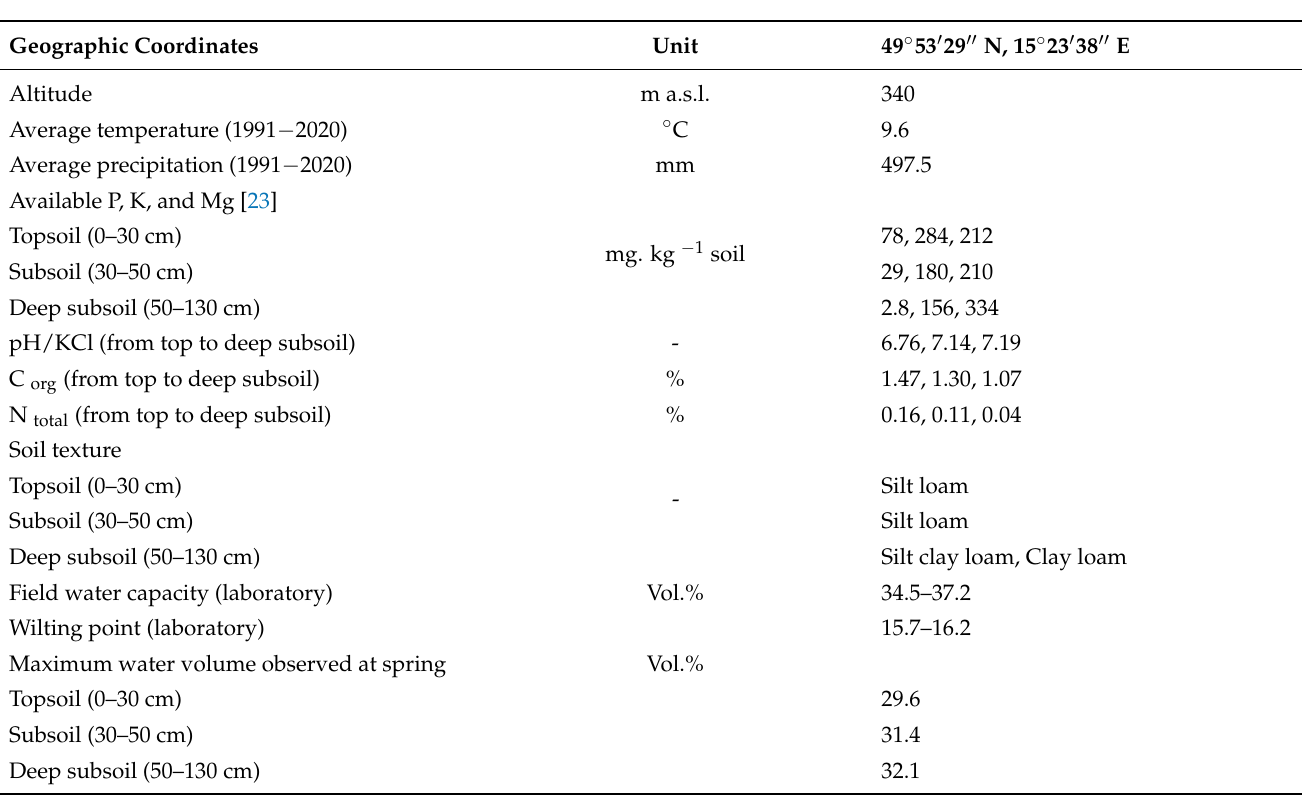
Figure 1. Experimental site. Table 1. Site